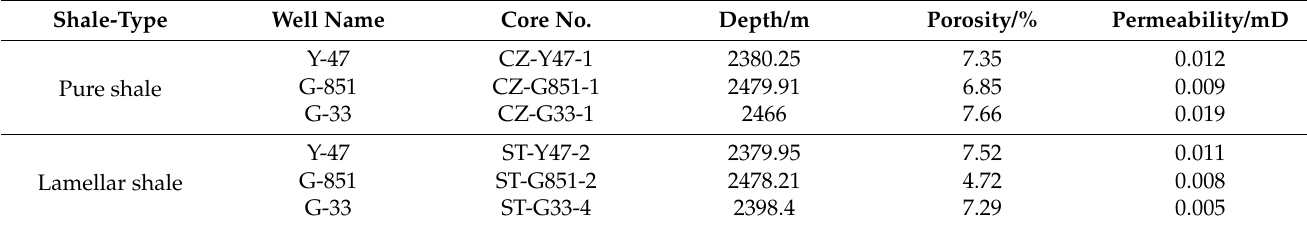
Table 1. Basic parameter of collected shale cores.